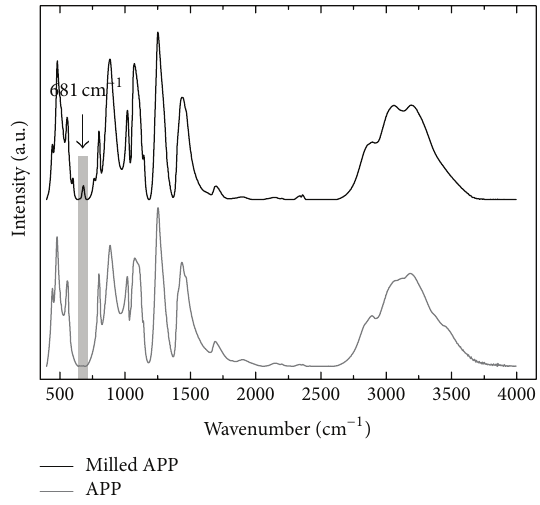
Figure 2: FTIR spectra of as-received and milled